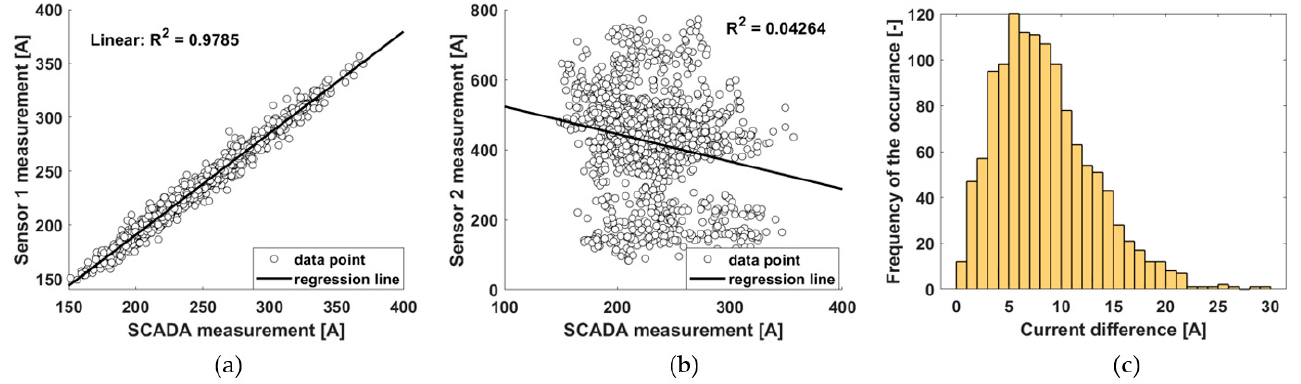
Figure 2. Line load measurement result, April 2020: ( a ) Measurement results of line monitoring sensor 1 compared to data from the SCADA system; ( b ) Measurement results of line monitoring sensor 2 compared to data from the SCADA system; ( c ) Difference between the maximum and minimum of the measured load values.